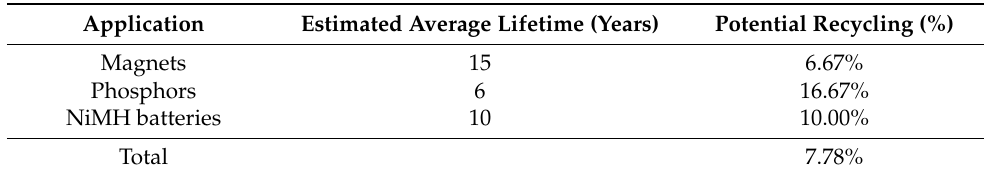
Table 6. Expected mean lifetimes and global recycling potential for REEs estimated for 2020 [modified after Binnemans et al. 2013